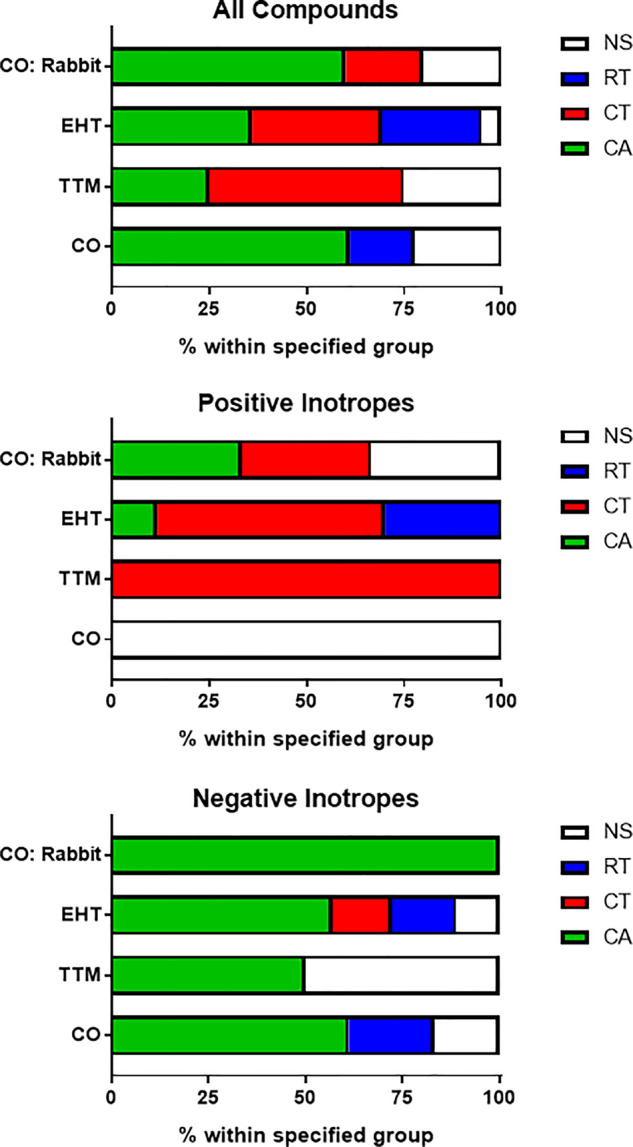
Most informative contractility marker. Parameters that led to the correct prediction of drug responses were assessed. Data show the breakdown by percentage for the parameters (CA, contraction amplitude; CT, contraction time; RT, relaxation time) that reached significance at the lowest concentration (Dunnett’s stats vs vehicle control and p < .05). White boxes (NS, not significant) indicate where predictions were made due to a trend rather than reaching significance, and/or by guidance from Ca2+ and/or voltage data. Abbreviations: CO, CellOPTIQ; EHT, engineered heart tissue; TTM, Triple Transient Measurement.